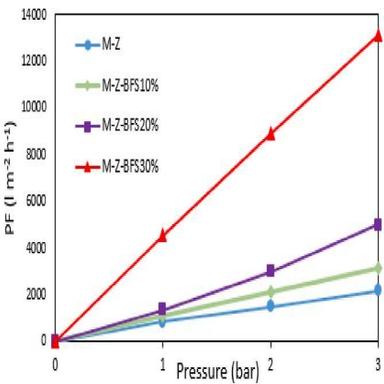
Pure water flux of M-Z, M-Z-BFS10, M-Z-BFS20 and M-Z-BFS30 sintered membrane.